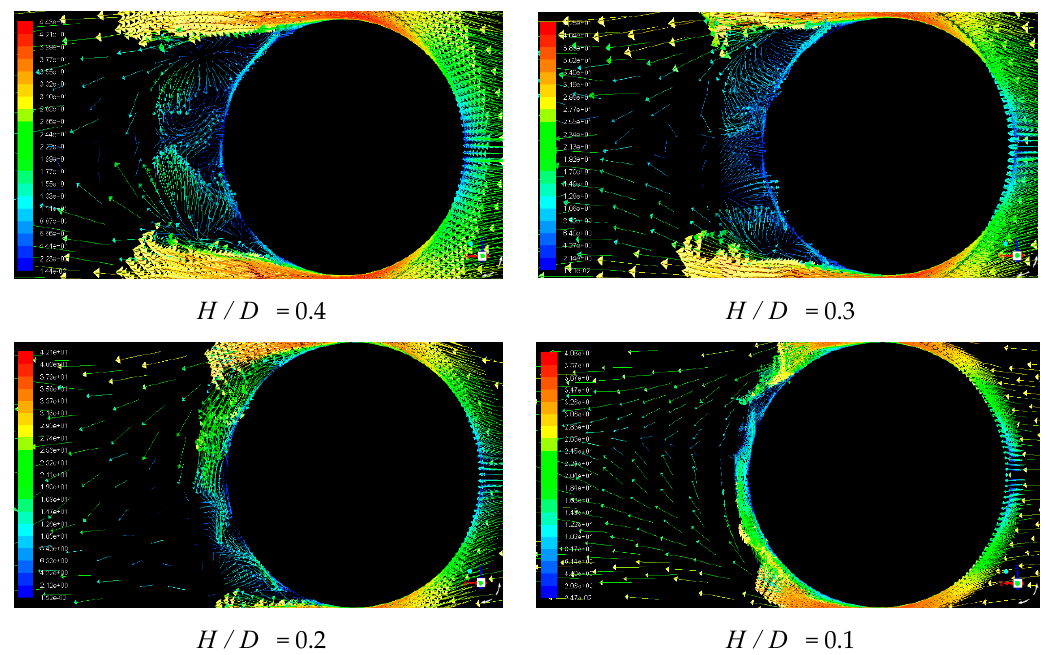
Figure 10. Instantaneous streamlines and contours of velocity in the horizontal center plane at y / D = 0 with different aspect ratios.